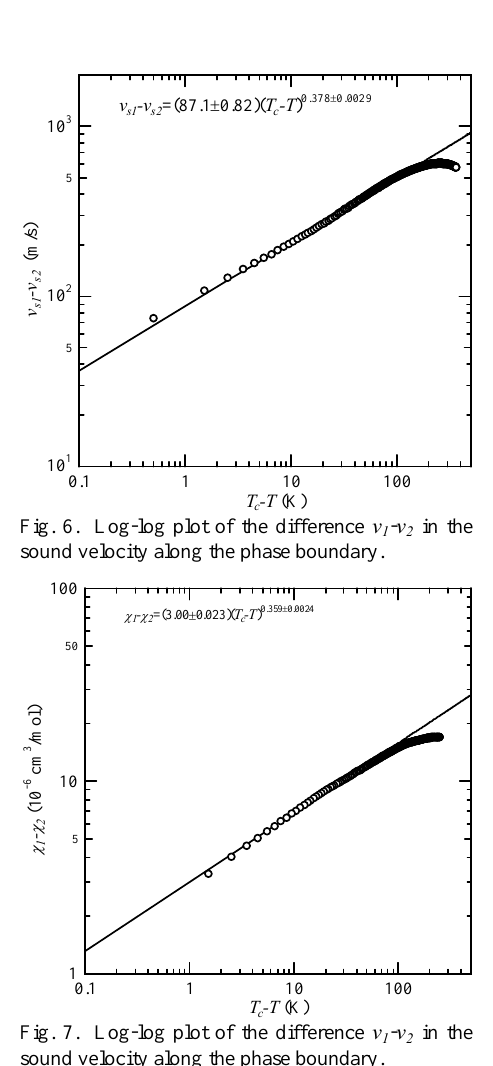
Fig. 7. Log-log plot of the difference v 1 - v 2 in the sound velocity along the phase boundary.